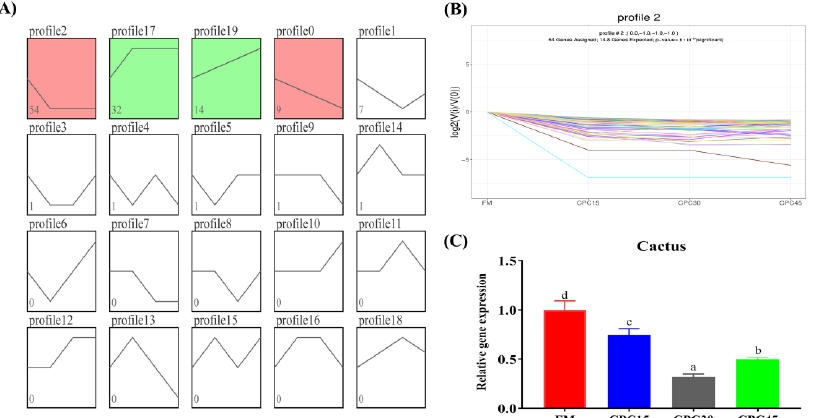
Figure 7. Trend analysis of shared differential genes. ( A ) analysis of shared gene trends. The difference is not significant for the white background and significant for the rest of the color background